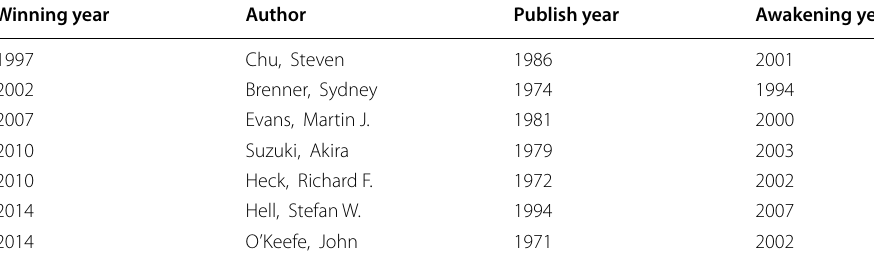
Table 7 Prize winning authors of SB Winning year